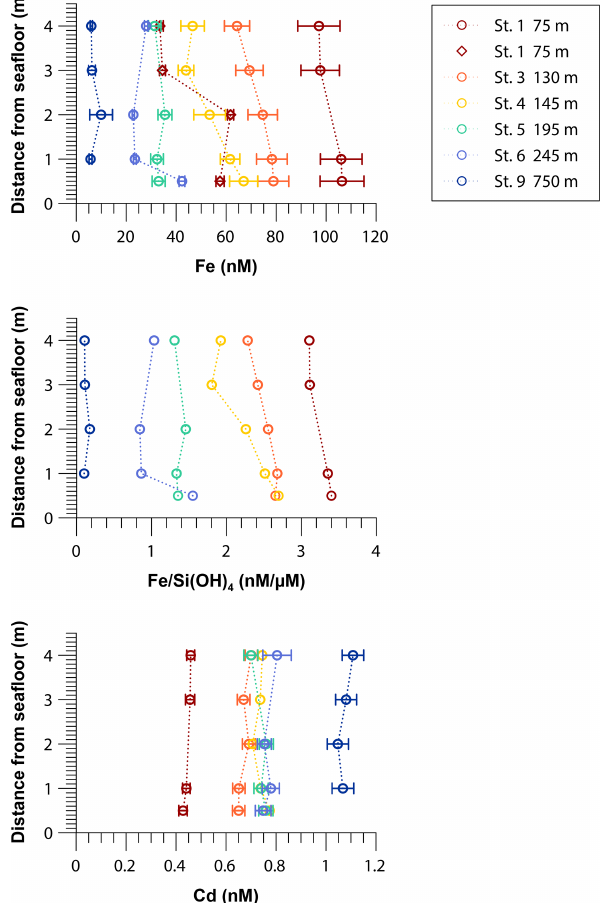
Figure 3. Near-bottom water concentrations of dissolved Fe and Cd and dissolved Fe to silicic acid ratios 0.5 to 4m above the seafloor across the 12 ◦ S transect. The red diamonds show results from a second sampling at Station 1 one month later. Concentrations of silicic acid are listed in Table